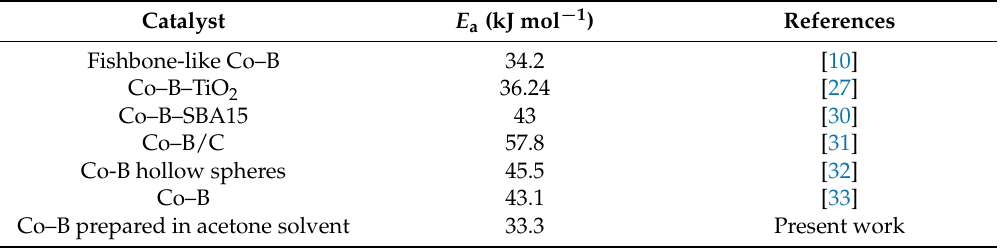
Table 3. Activation energy ( E a ) values for hydrolysis of NaBH 4 catalyzed by different Co–B catalysts.